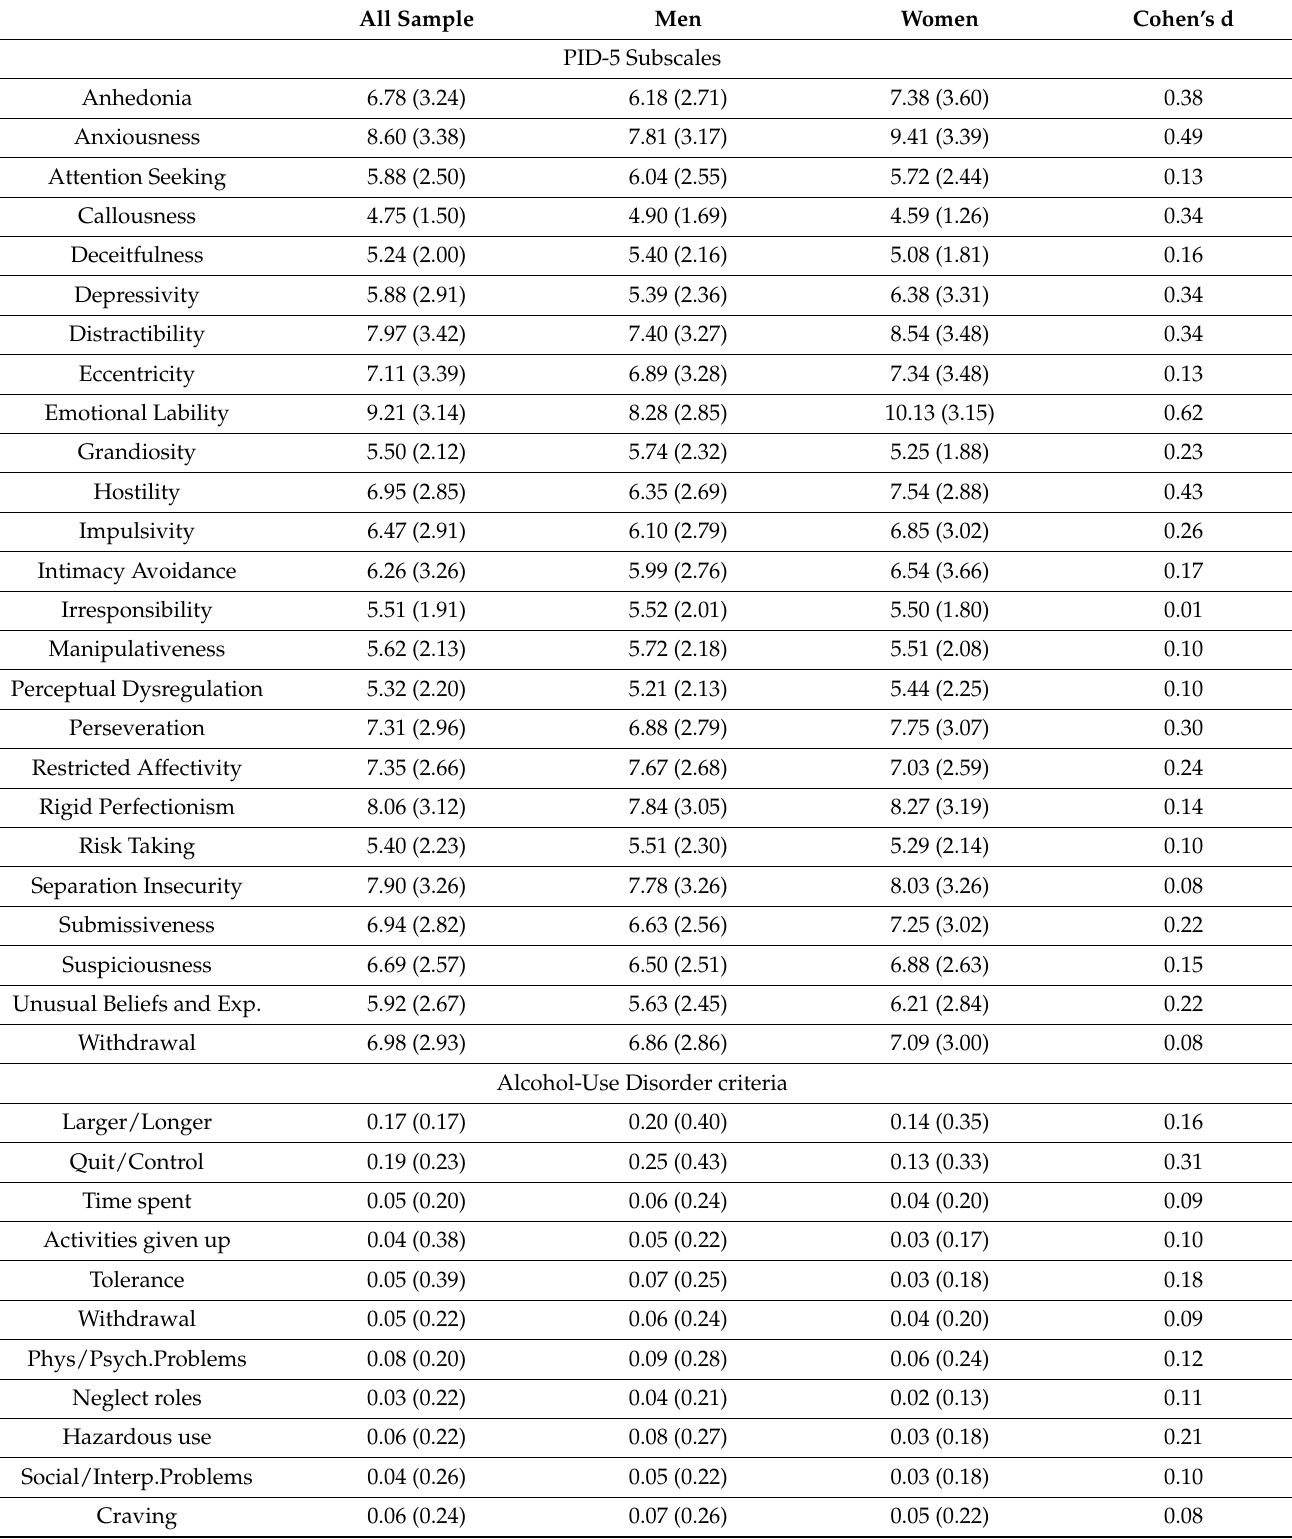
Table 4. Means, standard deviations, and Cohen’s d of scores on the PID-5-SF subscales and alcohol- use disorder